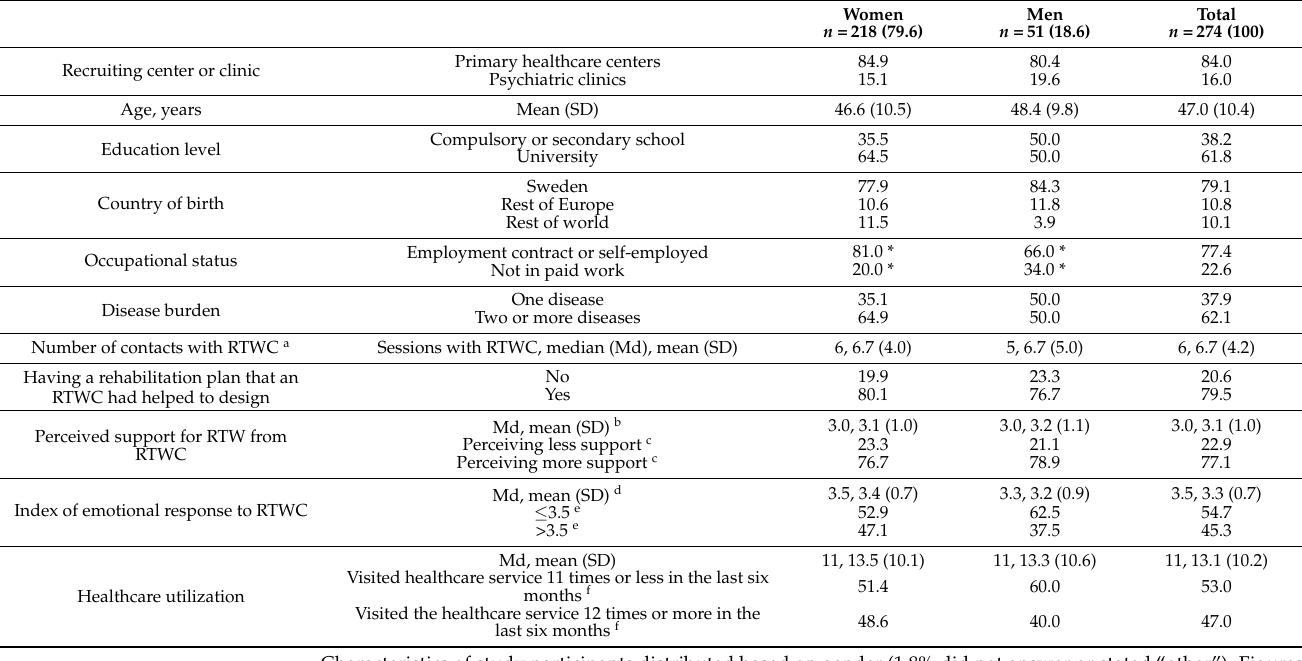
Table 1. Characteristics of study